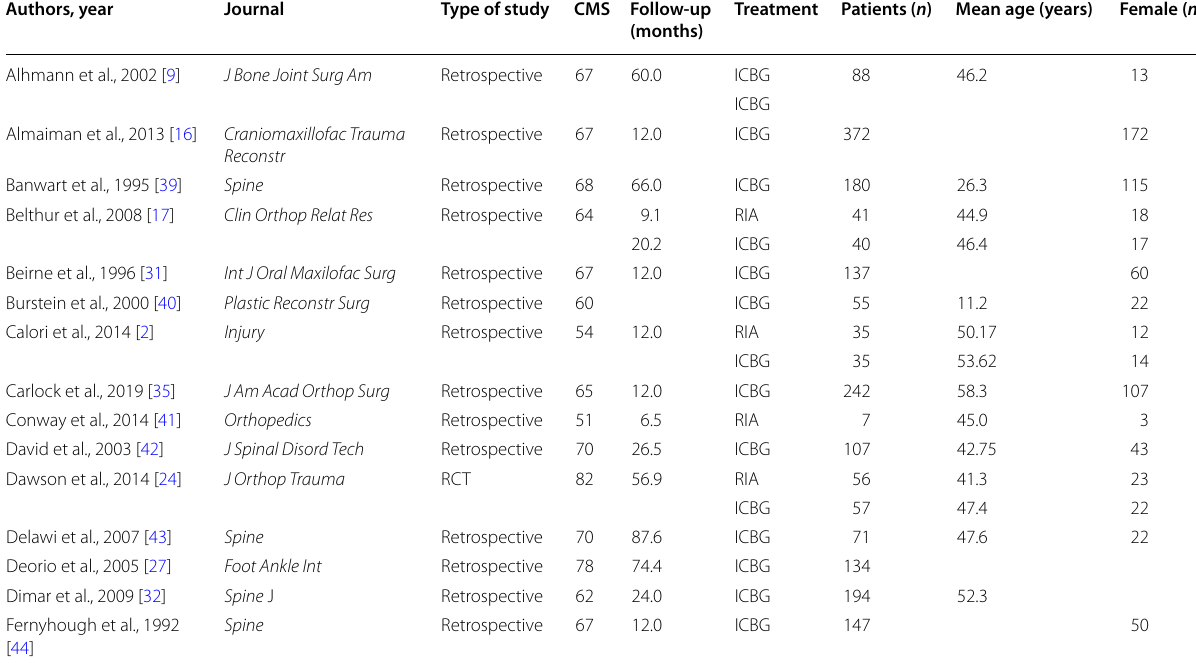
Table 2 Generalities and patient baselines of the included studies Authors,